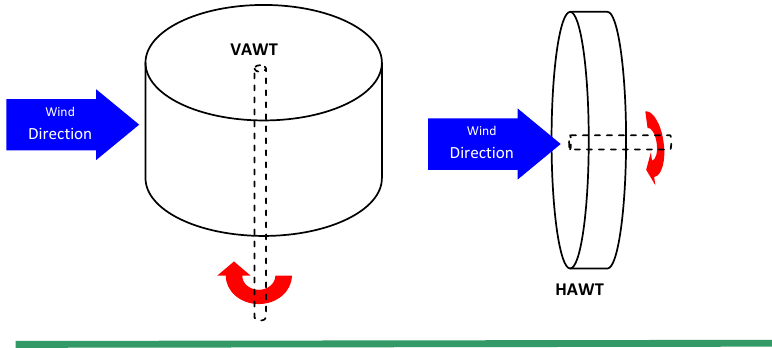
Figure 1. Alternative configurations for shaft and rotor